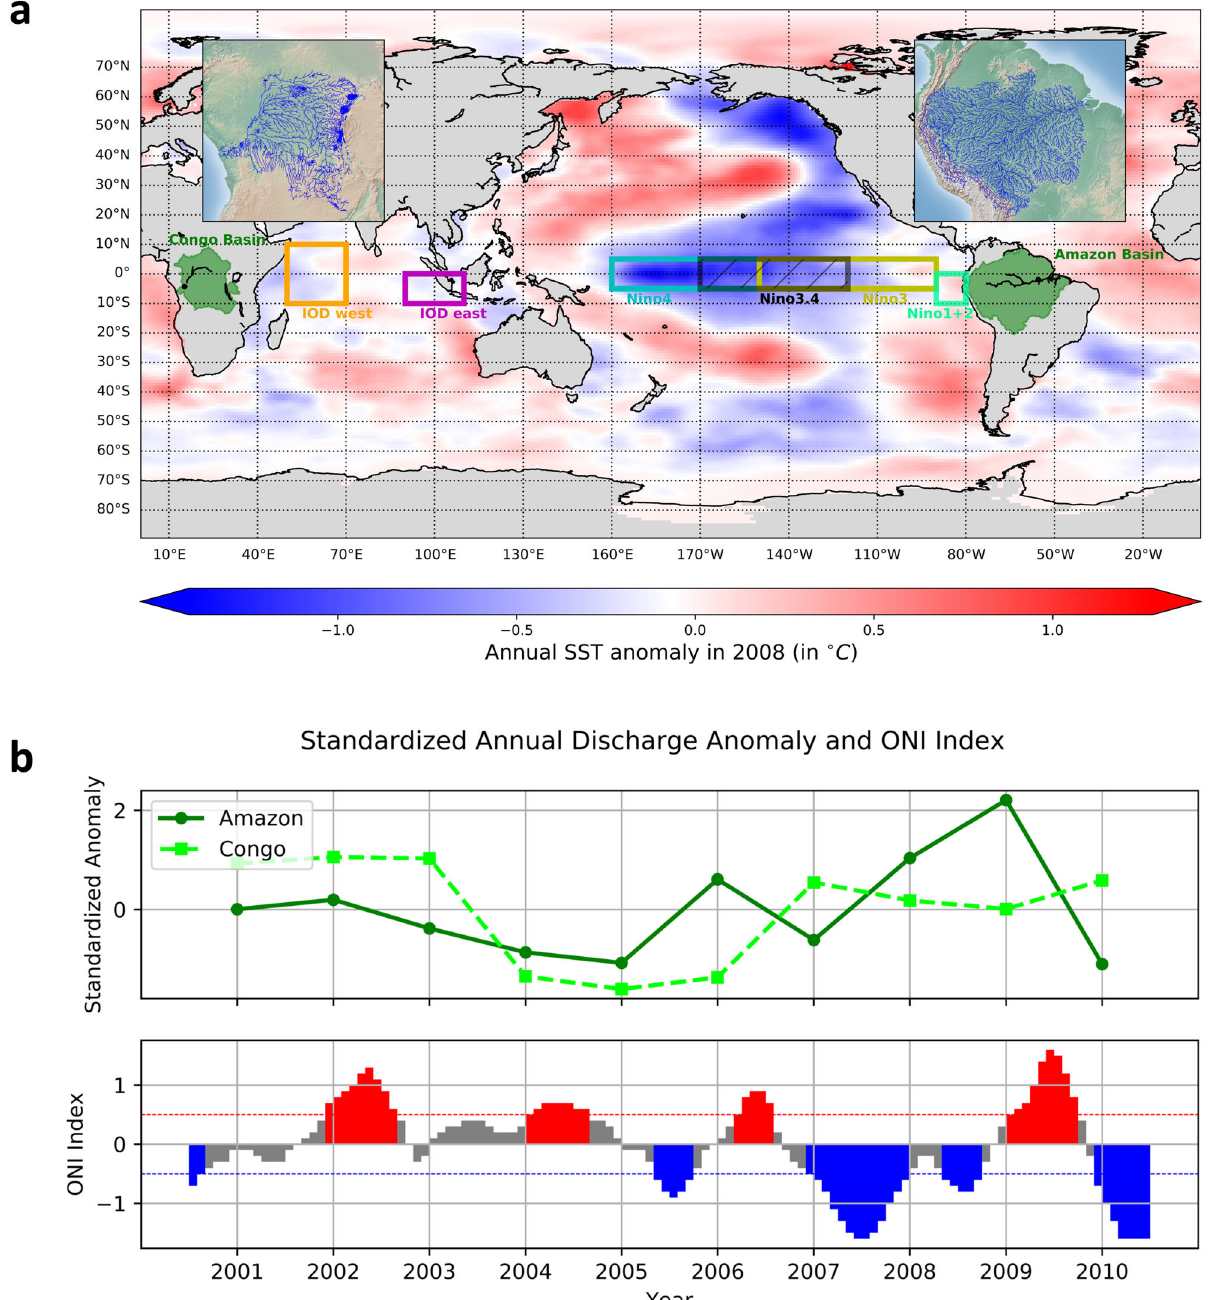
Fig. 1 | Global sea surface temperature fl uctuations including the El Niño Southern Oscillation impact interannual variability in the fl ow of large rivers such as Amazon and Congo. a Regions for calculating El Niño – Southern Oscilla- tion (ENSO) indices (Niño 1+2, Niño 3, Niño 3.4 and Niño 4) and Indian Ocean Dipole Mode Index (DMI), and two hydrological regions (Amazon River basin and Congo River basin). The colors shown on the ocean are the annual sea surface temperature (SST) anomaly in 2008, a La Niña year. b Time series of standardized annual river fl ow in m 3 /s for Amazon (green) and Congo (lime) and monthly